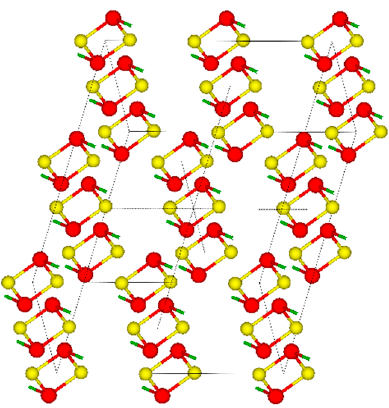
Figure 2. Schematic view of the supercell. Only Cu and S atom are